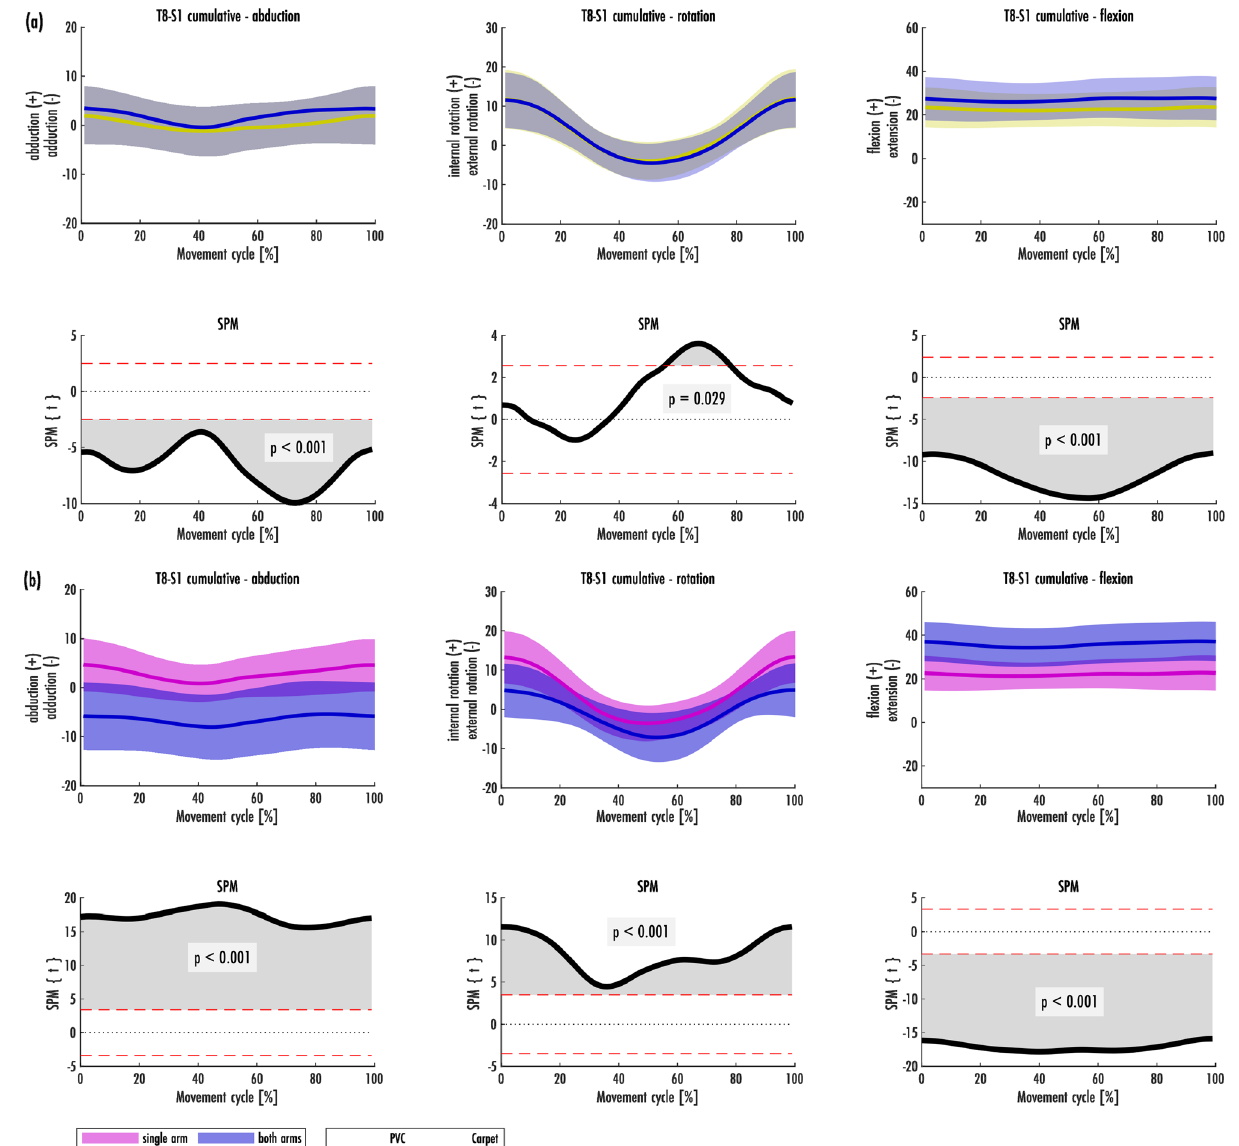
Figure 2. a , b Spinal movements of the T8-S1 cumulative joint T8–S1 in the habitual vacuuming cycle [mean and range of standard deviation (± SD)]. a Is group based on the carpet condition, b is the group based on the grip position. The result of the SPM is plotted directly underneath the mean and SD of the The mean standard deviation over the entire cycle was greatest in all joints in the dimension of flexion/ exten- sion compared to lateral flexion or abduction/ adduction and rotation. The largest mean standard deviations were observed in the C1-Head joint and the smallest in the T1-C7 joint. A summary of all the differences is given in Table 3. In general, the floor condition introduces smaller changes than the grip position. The difference between the PVC and carpet is in the range of 2° to 3°, while the difference between single arm and both arm holding is in the range of 5° to 10°. Motion profile: joint angular velocities. Table 4 shows the median with interquartile range (IQR) as well as the mean maximum and minimum velocity of the joint angular velocities of head/cervical spine, lower back and hip joints. Figure 4a, b shows the frequencies of the angular velocities of the cervical spine during habitual vacuuming. The C1-Head joint shows higher velocities in all three dimensions than the T1-C7 joint. Figure 5a–e shows the frequencies of angular velocities of the four single trunk joints and T8-S1 cumulative. The velocities in the joints L1–T12 and L4–L3 were identical. In all three dimensions, the velocity increased from T9–T8 to L5–S3. Overall, it can be observed that the angular velocities in the thoracic area are lower compared to the lower trunk and the cervical spine. The C1-Head joint had the highest mean maximum velocities of the spine, while the lowest maximum velocities were observed in T9–T8. Thus, less velocity was observed in the